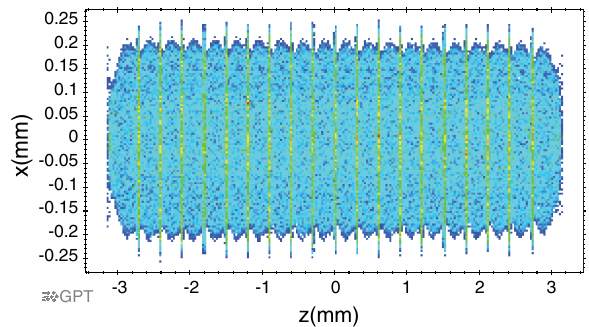
FIG. 3. Configuration space ( xz plane) at maximum current point. The initial bunching factor for this simulation is b ¼ 0 : 25